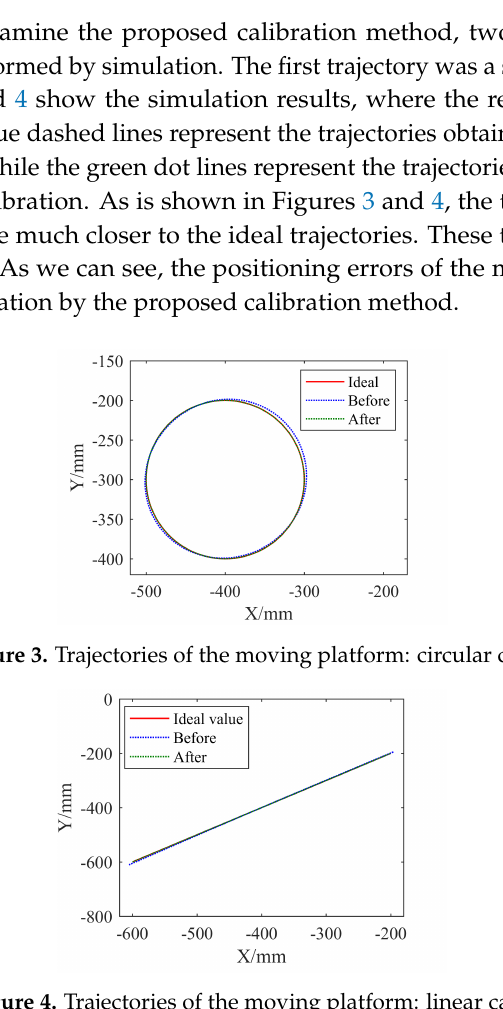
Figure 4. Trajectories of the moving platform: linear case.